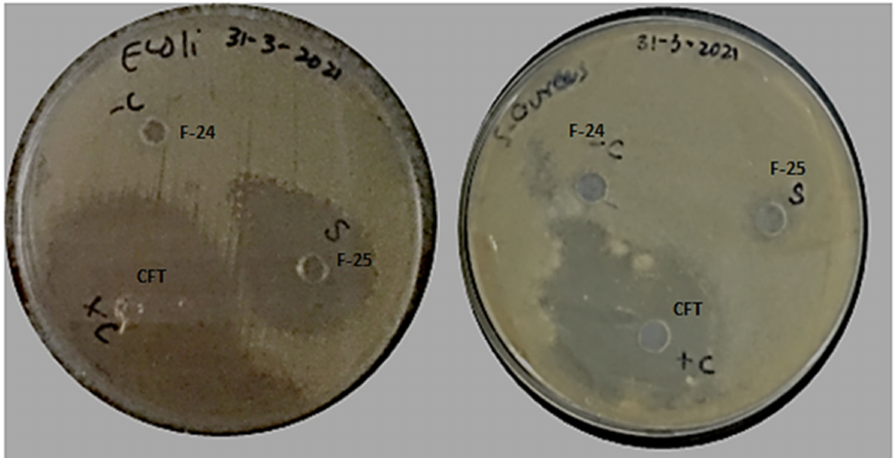
Figure 10. Antibacterial activity of blank NPs (F-24) and drug-loaded NPs (F-25) against E. coli and S. aureus